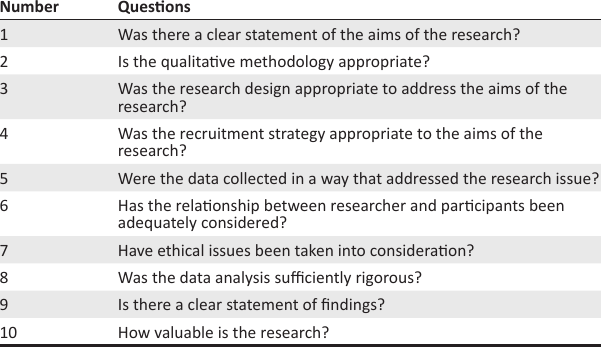
TABLE 2: Critical Appraisal Skills Programme (CASP) review questions.